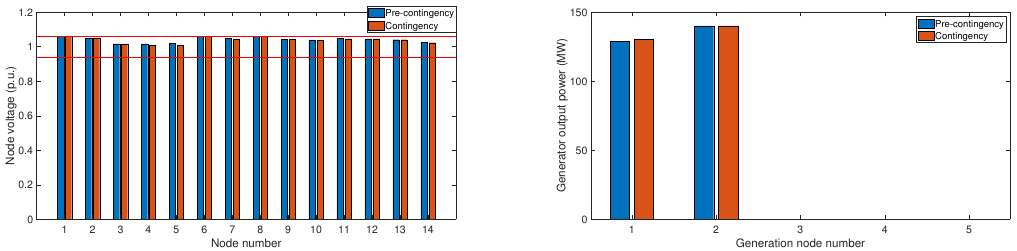
Figure 5. Voltage and power dispatched implementing the QCQP results in a power flow of the network prior to and after contingency of branch 5 (generation nodes are, respectively, 1, 2, 3, 6, and 8).